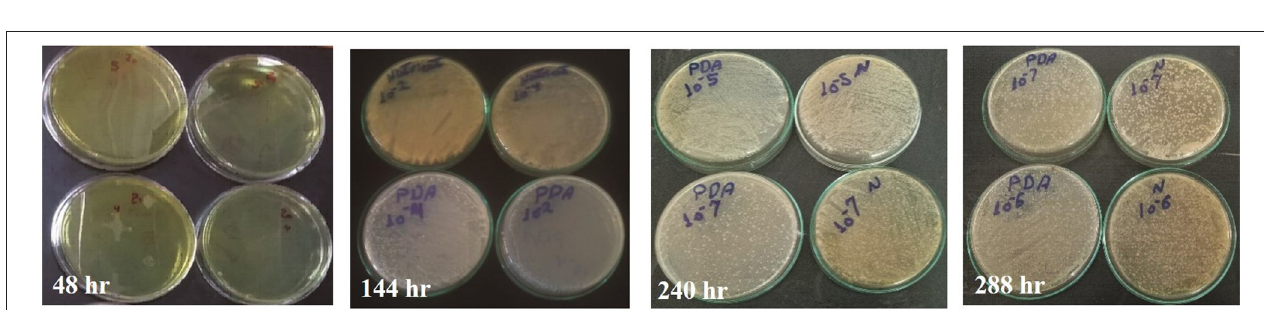
FIGURE 4 | Petri dish photos of microbial activity assay of fresh cooling fish filet with different concentrations ( µ g/mL) over different incubation time 48, 144, 240, and 288 h.